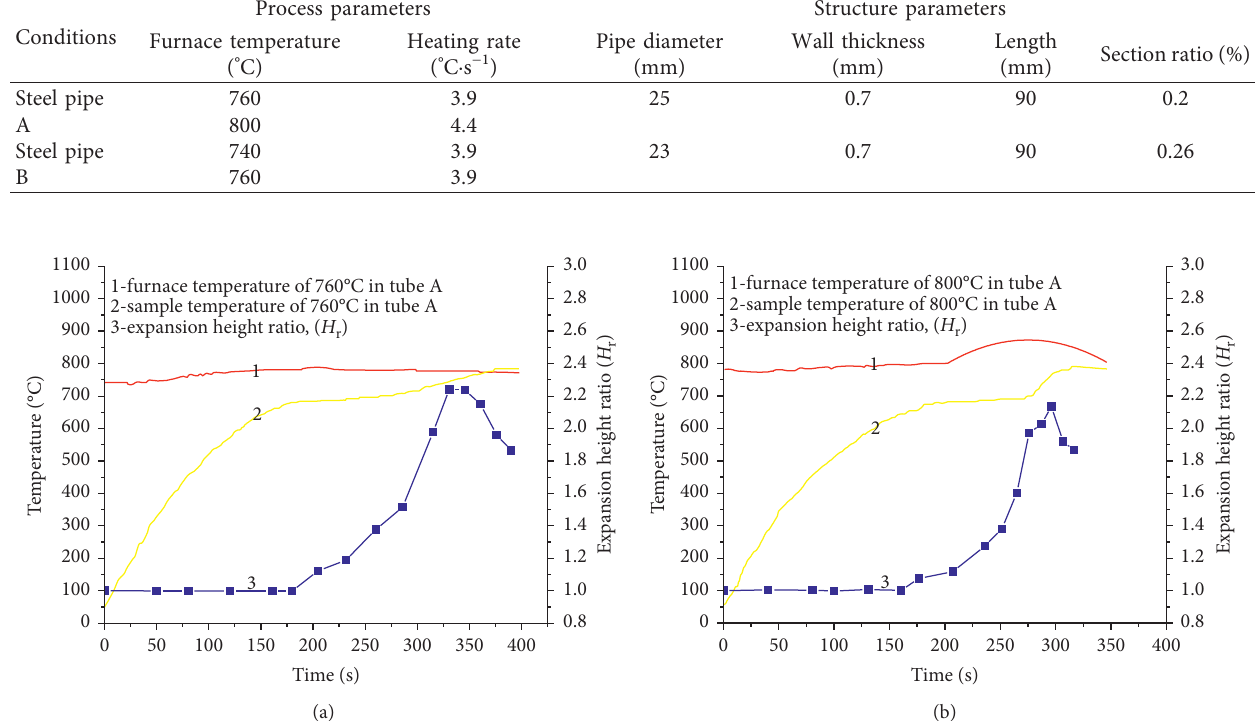
Figure 2: Temperature rise-expansion curves of the sample in pipe A at furnace temperatures of 760 ° C (a) and 800 ° C (b).